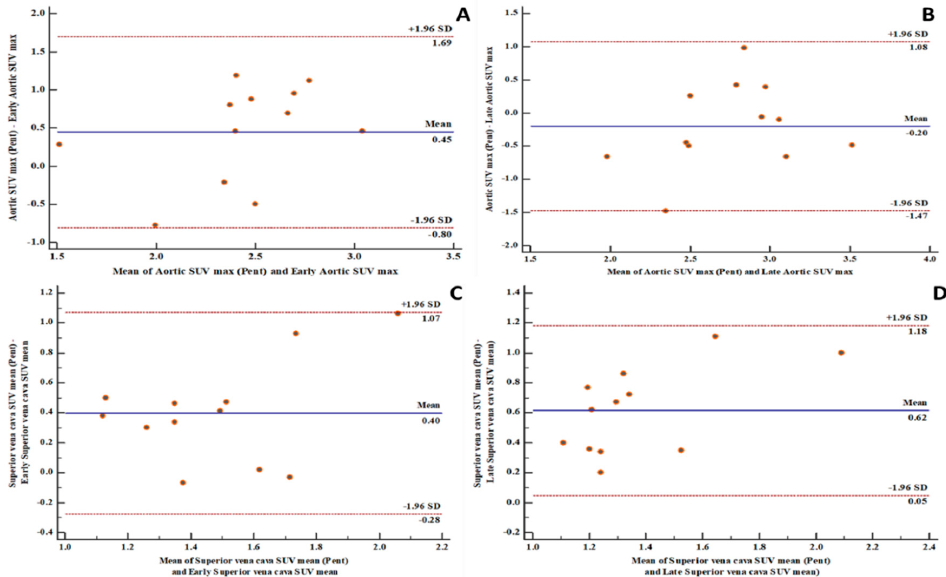
Figure 1. Bland and Altman plots showing good levels of agreement between fluorine-18 fluorodeoxyglucose positron emission tomography/computed tomography ([ 18 F]FDG PET/CT) and Gallium-68pentixafor positron emission tomography/computed tomography ([ 68 Ga]Ga-pentixafor PET/CT)-derived variables: ( A ) a good level of agreement between [ 68 Ga]Ga-pentixafor PET-derived aortic maximum standardized uptake value (SUVmax) and [ 18 F]FDG PET-derived early aortic SUVmax with 100% of measurements within the limits of agreement; ( B ) a good level of agreement between [ 68 Ga]Ga-pentixafor PET-derived aortic SUVmax and [ 18 F]FDG PET-derived late aortic SUVmax with 91.7% of measurements within the limits of agreement; ( C ) a good level of agreement between [ 68 Ga]Ga-pentixafor PET-derived superior vena cava mean standardized uptake value (SUVmean) and [ 18 F]FDG PET-derived early superior vena cava SUVmean with 100% of measurements within the limits of agreement; ( D ) a good level of agreement between [ 68 Ga]Ga-pentixafor PET-derived superior vena cava SUVmean and [ 18 F]FDG PET-derived late superior vena cava SUVmean with 100% of measurements within the limits of agreement. SD: standard deviation.